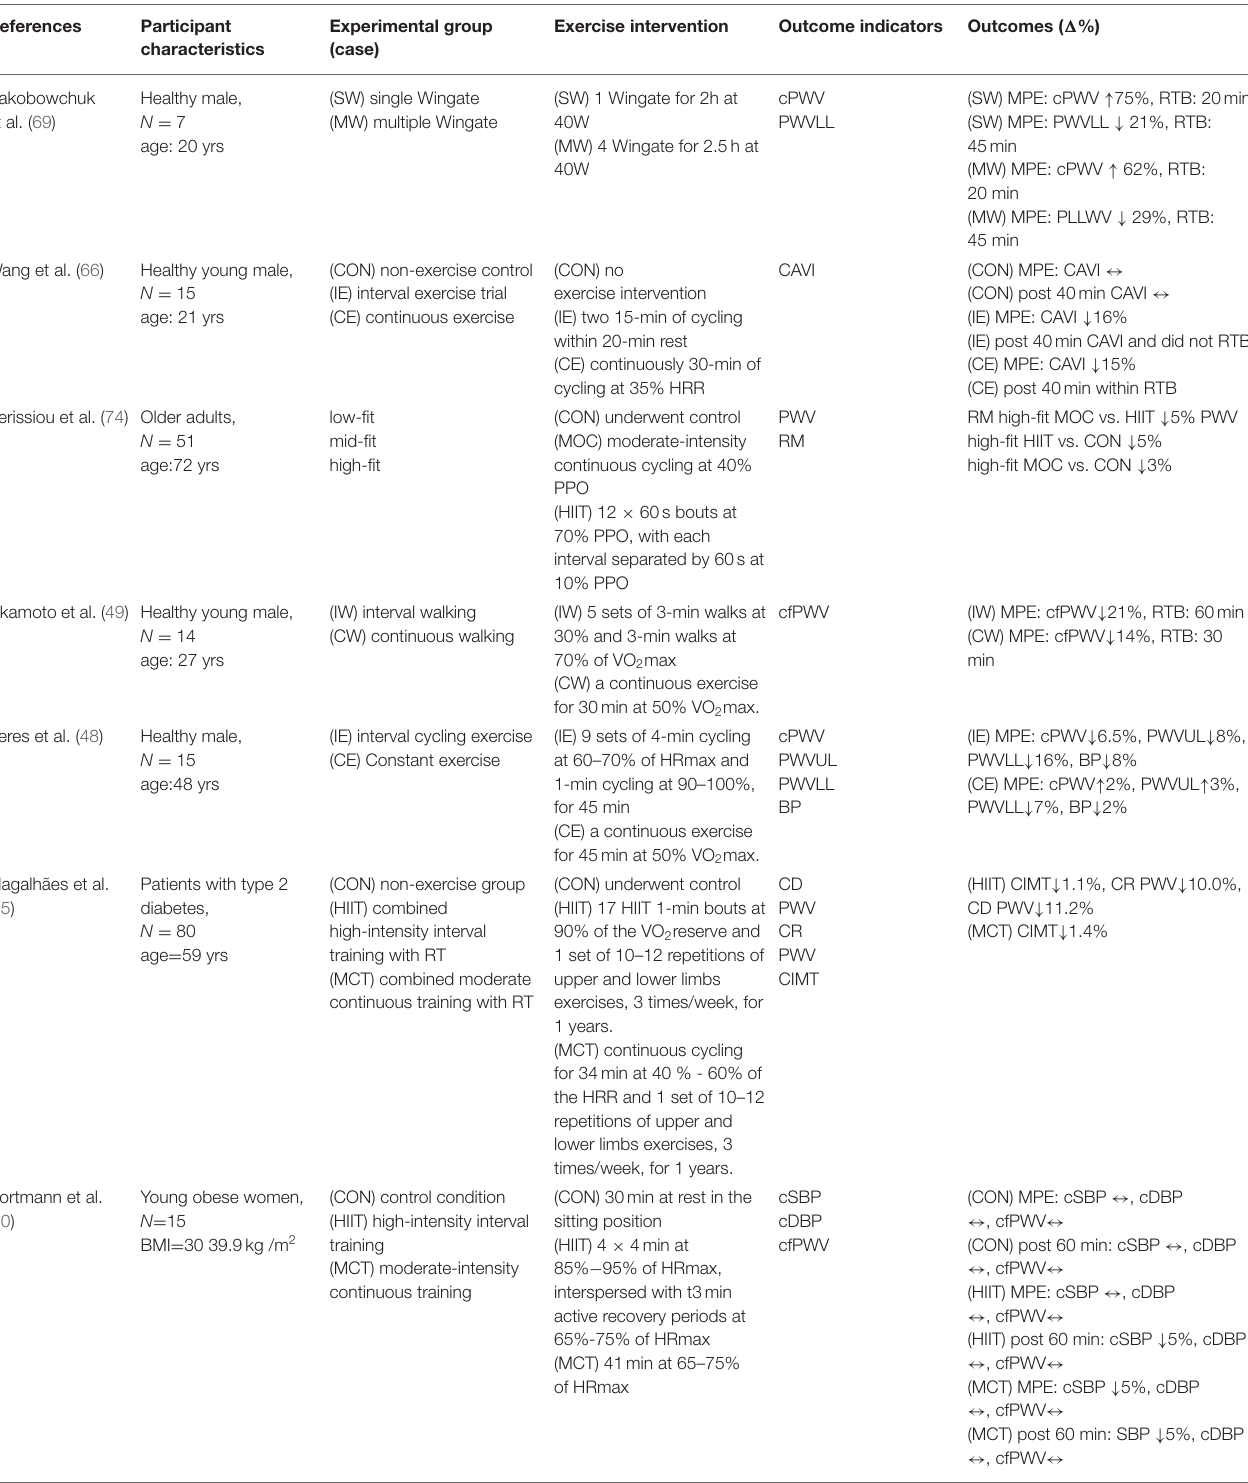
TABLE 2 | Comparison of high-intensity interval training and continuous training on arterial stiffness in response to acute